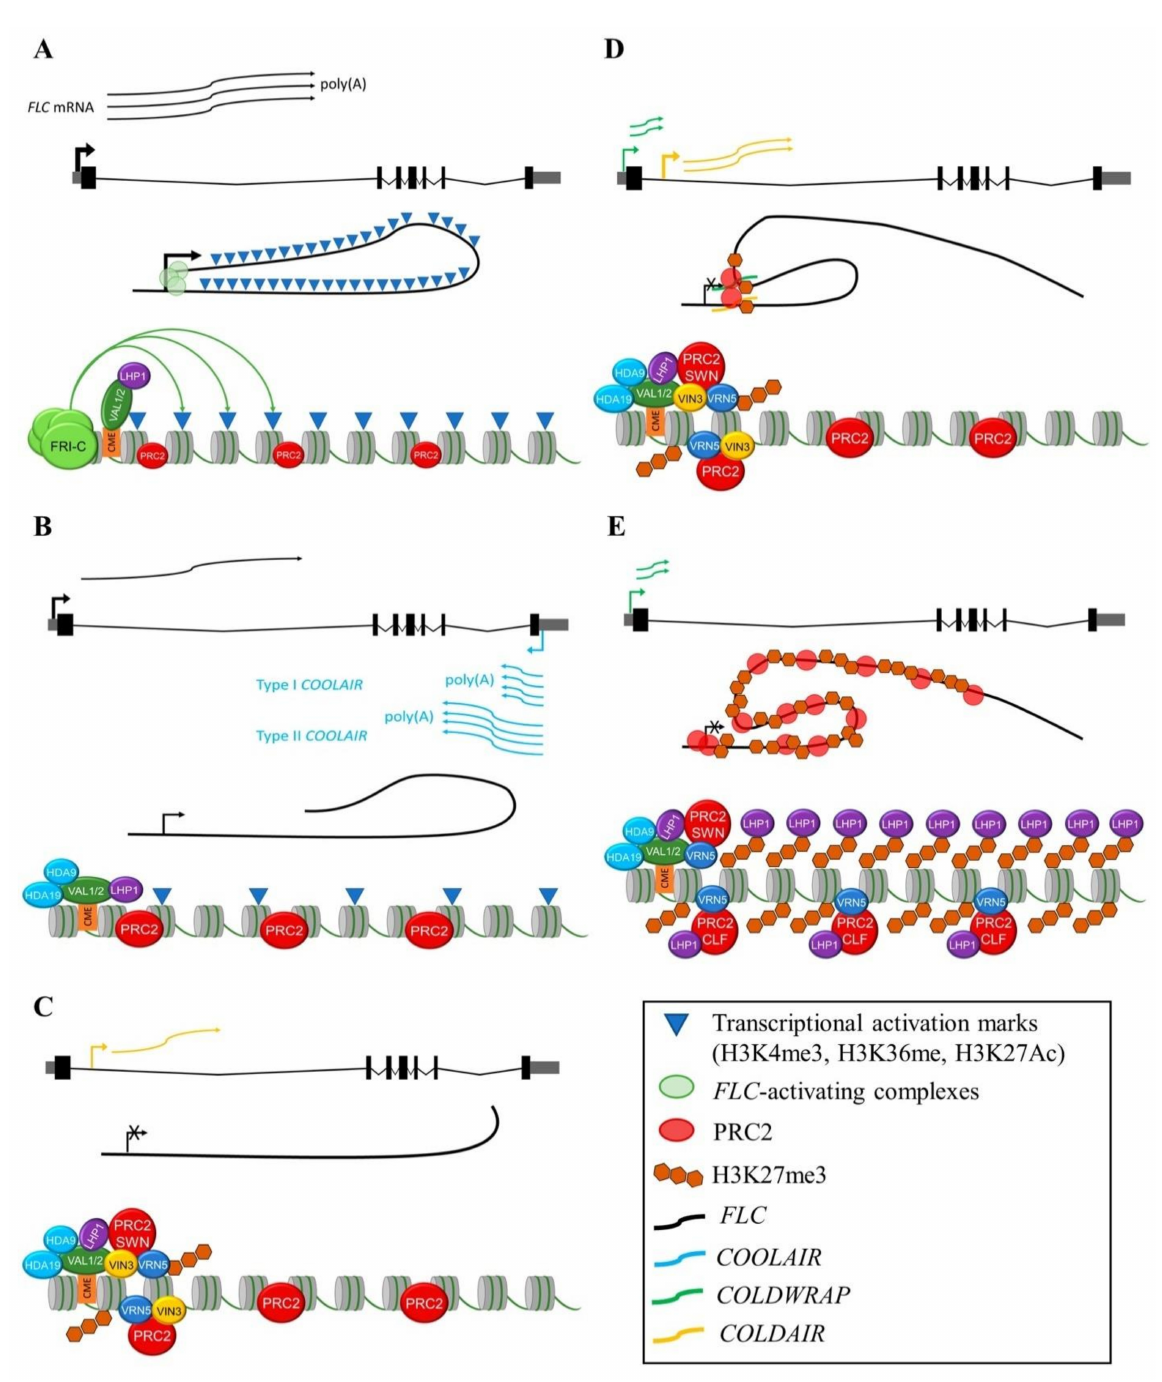
Figure 1. FLC silencing events during vernalization. Epigenetic factors and non-coding RNAs carry out this process. ( A ) Before vernalization, FLC is transcriptionally active. ( B ) Initial FLC silencing by cold-induced COOLAIR (type I). ( C ) The PHD dimer VIN3 and VRN5 binds to the PRC2 complex increasing the deposition of the H3K27me3 mark at the nucleation region. ( D ) After prolonged exposure to cold, COLDAIR and COLDWRAP in association with PRC2 promote the formation of a repressive chromatin loop reinforcing FLC silencing. ( E ) Spreading of the H3K27me3 mark by CLF is maintained by LHP1 after plants returned to warm temperatures. A scheme of the FLC gene and the mRNAs produced (top), the FLC DNA structure (middle), and some of the proteins participating in nucleosome modifications (bottom) are shown in each